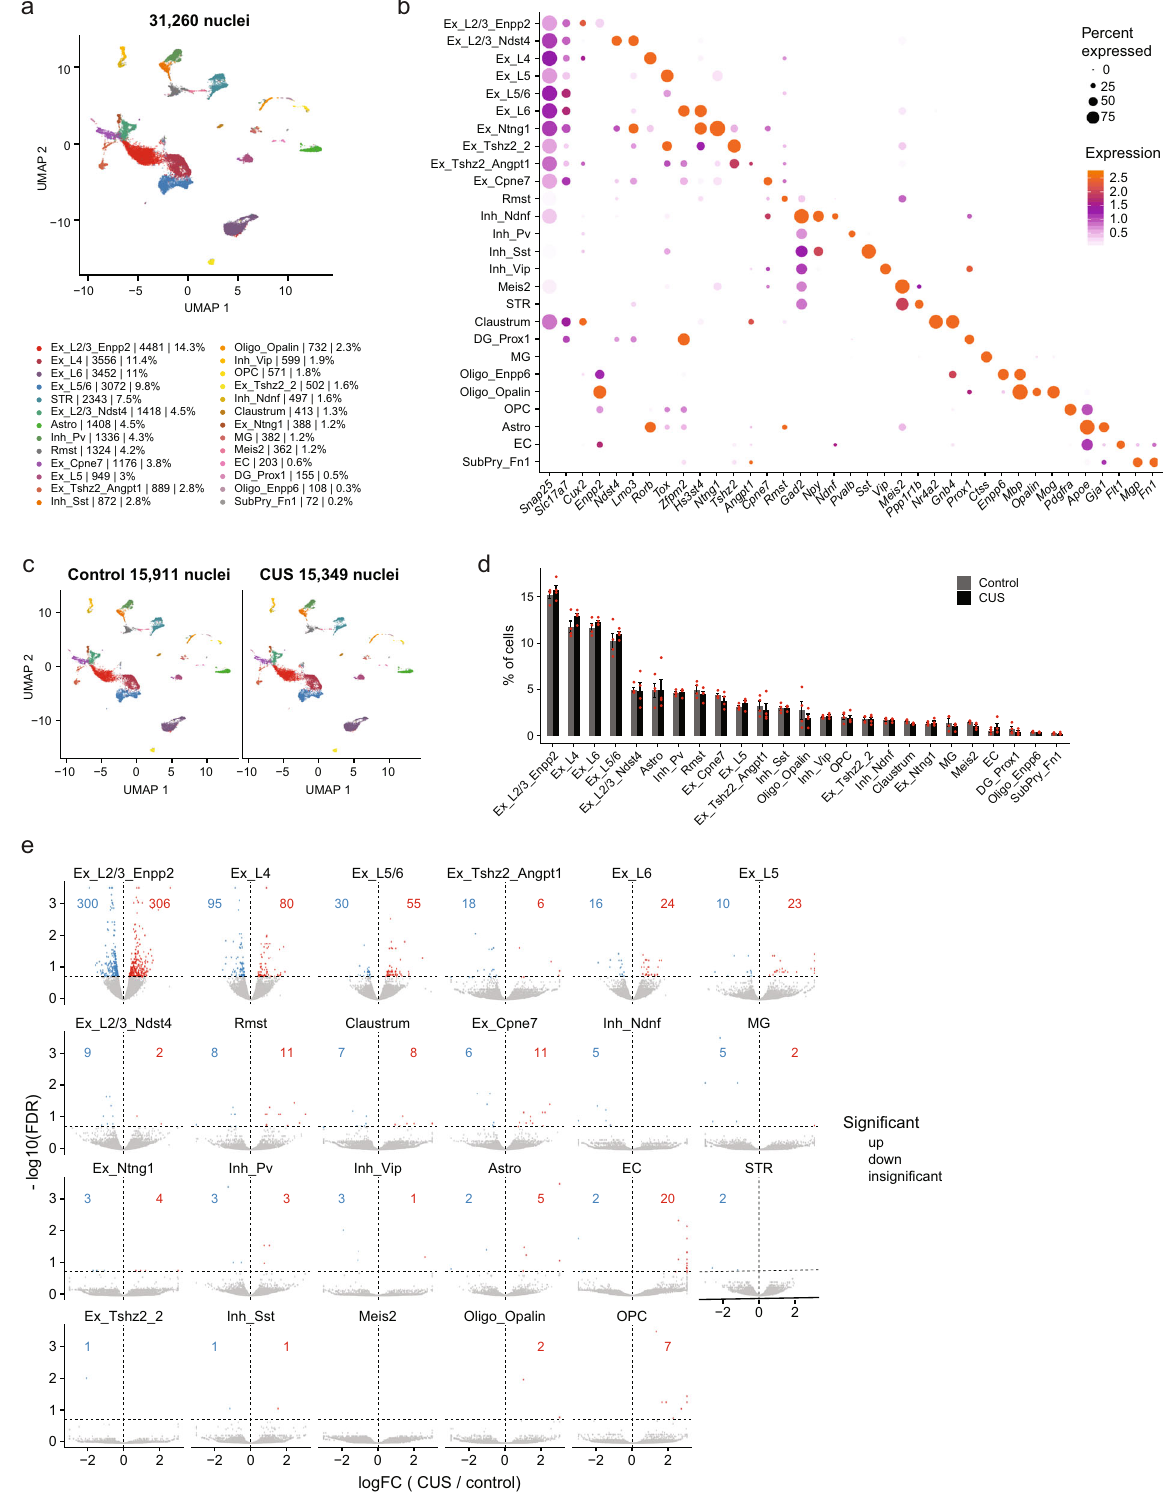
Fig. 3 Identi fi cation of CUS-driven cortical cell type-speci fi c gene expression changes using single-nucleus RNA-sequencing. a Visualization of UMAP plot displaying 26 clusters segregated from all 31,260 nuclei isolated from adult control and CUS mouse cortices ( n = 8 mice). Ex, excitatory neurons; Inh, inhibitory neurons; Astro, astrocytes; OPC, oligodendrocyte precursor cells; Oligo, oligodendrocytes; MG, microglia; EC, endothelial cells. b Bubble chart showing expression of cell type-speci fi c marker genes for each cortical cell cluster. c UMAP plots depicting clusters identi fi ed from control (15,911 nuclei) and CUS nuclei (15,349 nuclei). d Percentage of control and CUS nuclei for every cortical cluster ( n = 4 each group). e Volcano plots of differentially expressed genes between control and CUS cortical nuclei (FDR < 0.2). Upregulated genes are shown in red, downregulated genes are displayed in blue, and insigni fi cant genes are shown in gray. Error bars represent